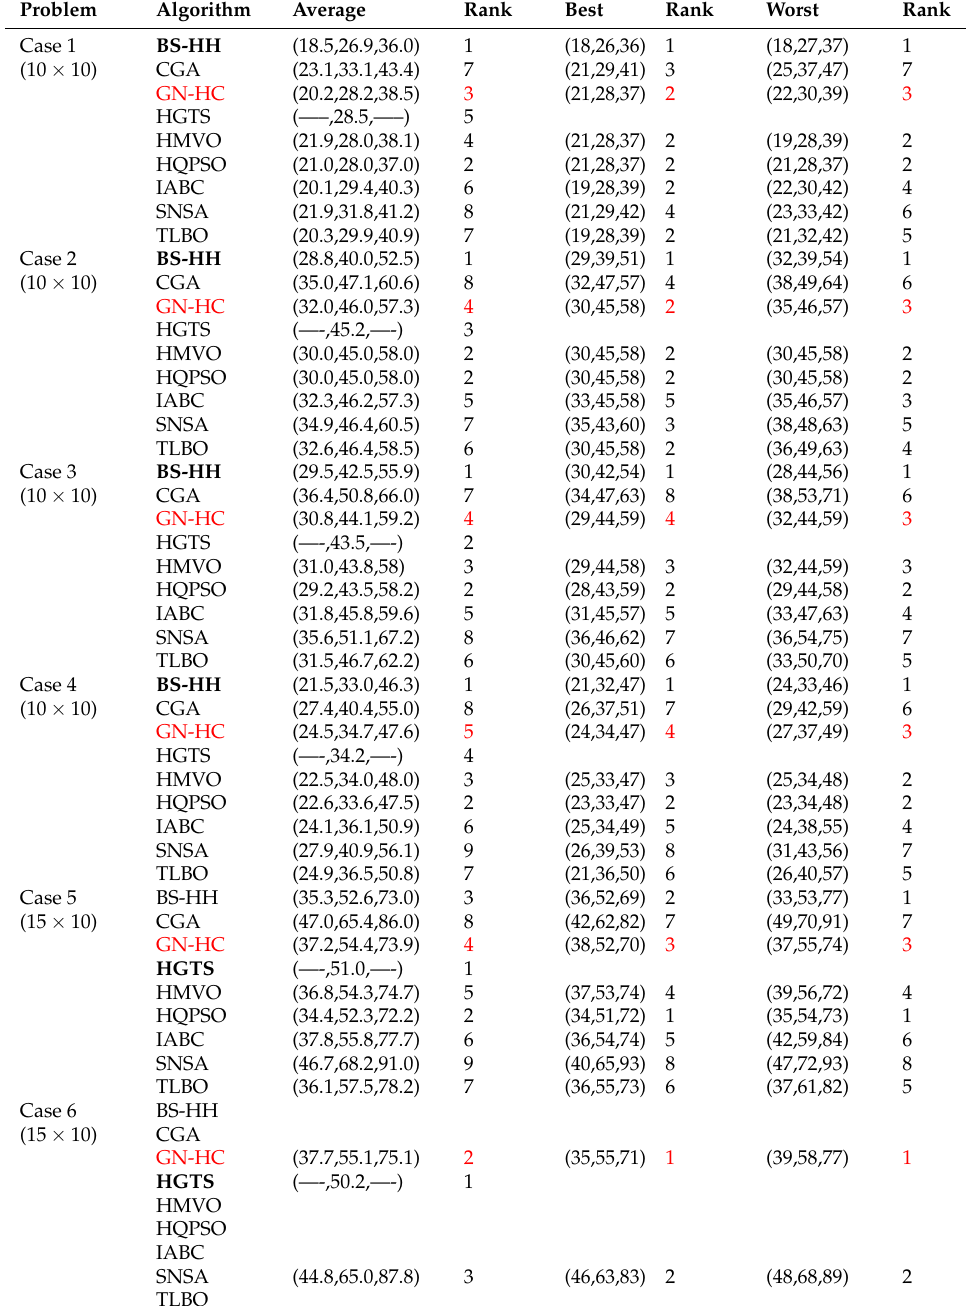
Table 1. Experimental results of GN-HC and its comparison with various metaheuristics for Lei instances.